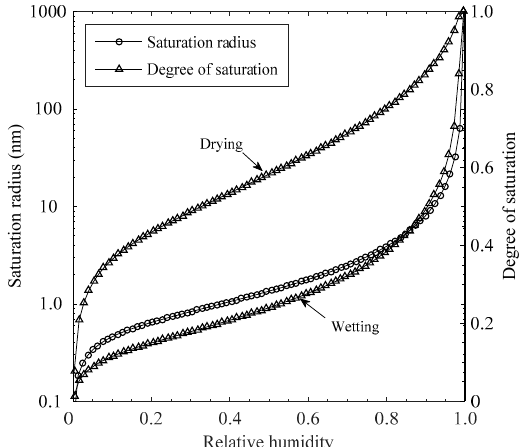
Figure 2. Moisture isotherms under drying and wetting together with saturation radius varying with relative humidity levels. By applying the calculated degrees of saturation under drying and wetting to Equation (21), it is possible to obtain the percolating pore fraction for diffusive